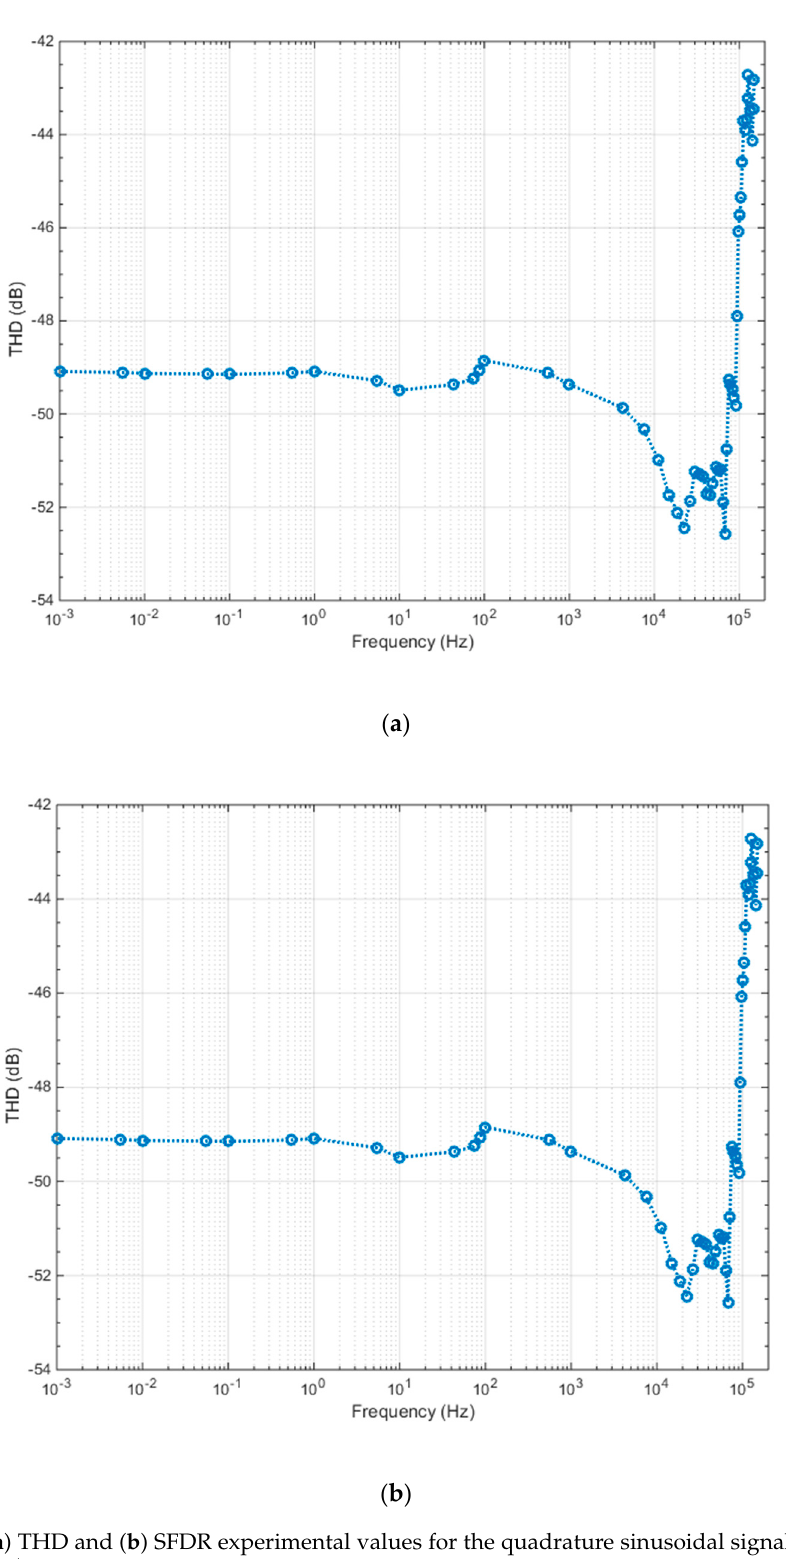
Figure 6. ( a ) THD and ( b ) SFDR experimental values for the quadrature sinusoidal signals. THD is defined as (cid:3493)∑ 𝐻 (cid:3036) (cid:2870)(cid:2875) (cid:3036)(cid:2880)(cid:2870) /𝐻 (cid:2869) , where H 1 is the contribution of the fundamental frequency of the sinusoidal signal, and H i are the successive harmonic contributions. SFDR is defined as H 1 / M , where M is the tone with the highest contribution which differs from H 1 . Both estimators are represented in decibels.